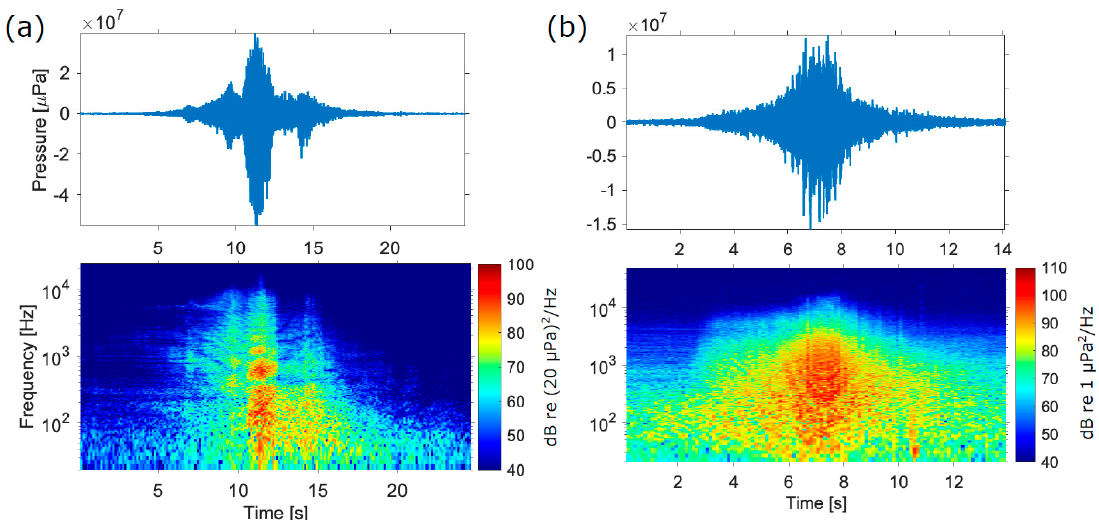
Figure 2. Waveform (top) and spectrogram (bottom) of ( a ) a Growler overflight recorded in air (fs = 48 kHz, NFFT = 12,000, 50% overlap) and ( b ) a Growler overflight recorded under water (fs = 96 kHz, NFFT = 24,000, 50% overlap).